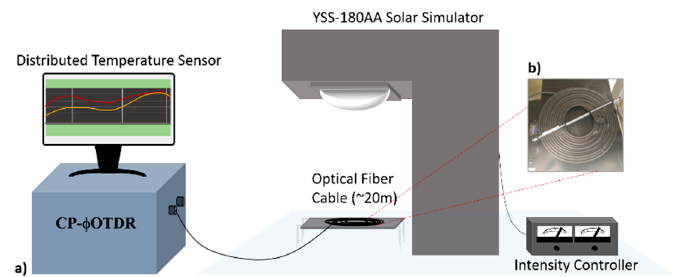
Figure 4. ( a ) Experimental setup proposed for the application and detection of solar irradiance; ( b ) Standard black telecommunications fiber cable, implemented as the fiber under test.